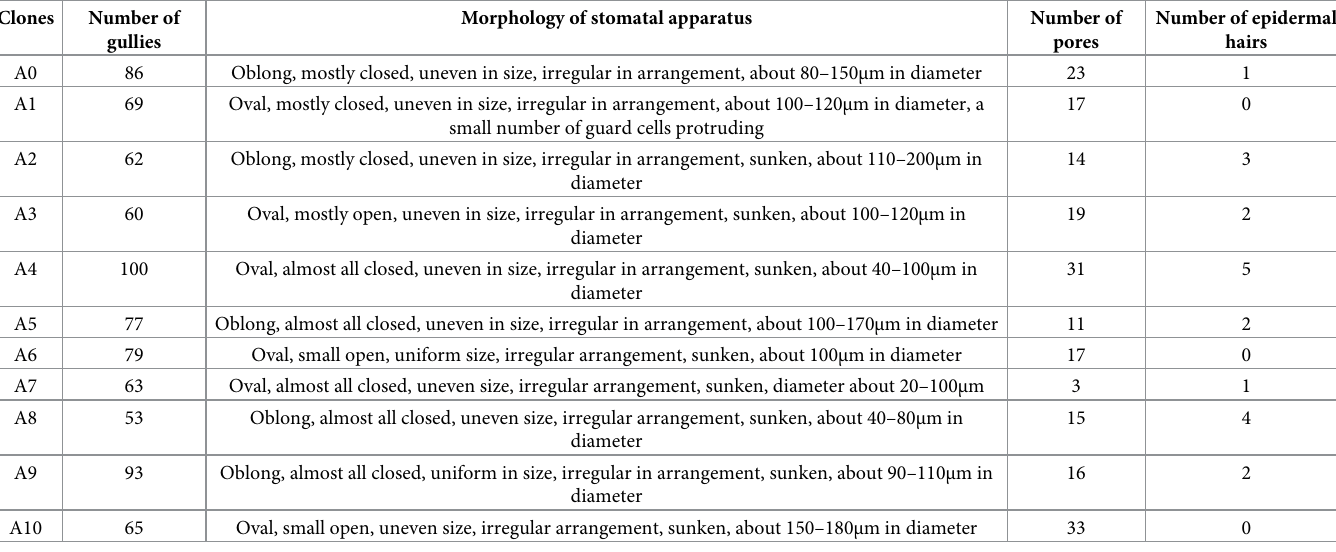
Note: Numbers of surface hairs and gullies represent 500 times their sum on the upper and lower surfaces of the visual field of the scanning electron microscope